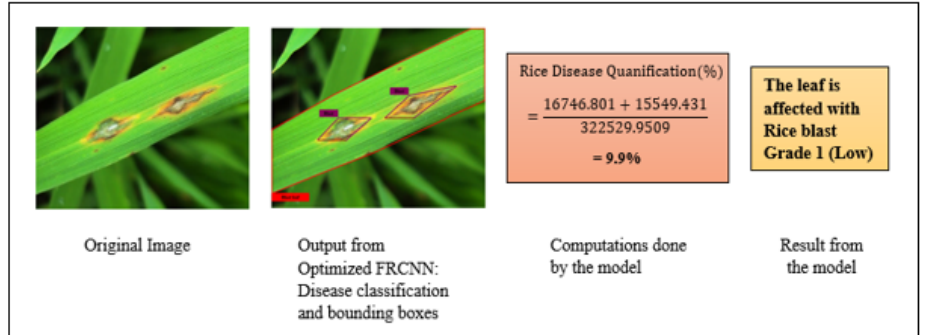
Figure 11. Rice grade model: original image, classification, and boundary box from FRCNN, compu- tations, and